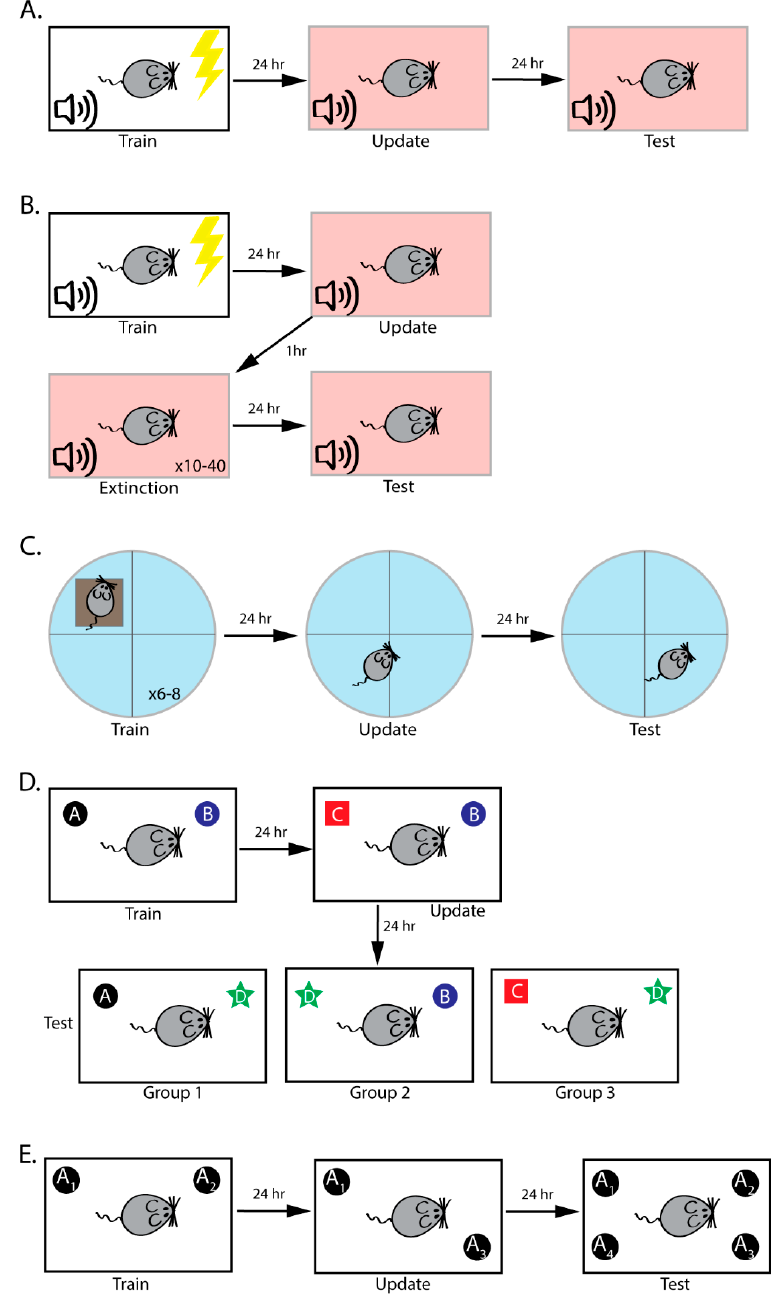
Figure 1. Schematics of common paradigms used to study reconsolidation-dependent memory updating. ( A ) A typical fear conditioning-reconsolidation experiment. Animals are initially trained to learn the CS-UCS association. Pictured, a tone CS is paired with a footshock UCS. Then, 24 hours later, animals are placed in a new context (peach background) and exposed to the CS to drive memory retrieval and updating. On the final day, the animal is presented with the auditory CS in the retrieval context. Throughout the experiment, freezing is measured as an index of fear. ( B ) Typical procedure for the reconsolidation-extinction paradigm. Training and retrieval sessions are identical to (A). One hour following retrieval, the animals are placed back into the retrieval context and the CS is presented multiple times to extinguish the fear memory. Extinction memory is tested the following day, with